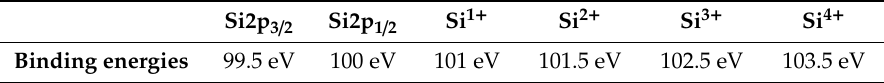
Table 4. Binding energies of the Si core levels and the Si oxidation states.